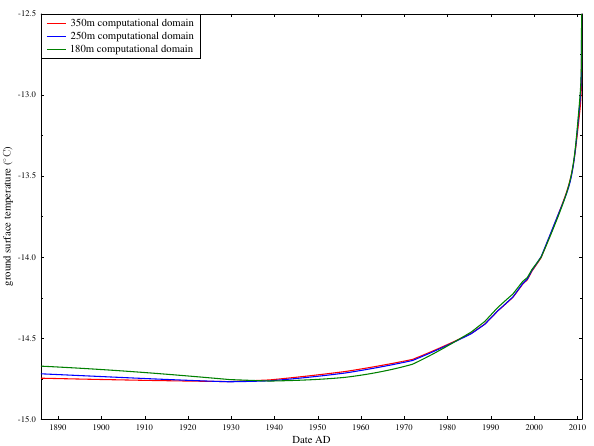
Fig. 5. Sensitivity of the ground surface temperature reconstruction to the depth of the computation domain, and hence the position of the zero heat flux boundary condition.